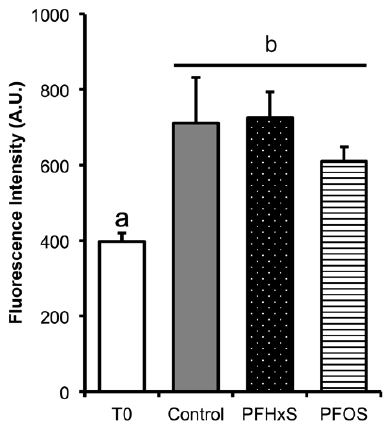
Figure 7. Flow cytometry of tyrosine phosphorylation in boar sperm. The fluorescence intensity obtained by fluorophore Alexa 488 were determined as arbitrary units (AU) did not show significant di ff erences in any of the capacitation conditions tested. A significant di ff erence was observed with the control at time T0, n = 3. a, b Di ff erent lowercase letters indicate the existence of significant di ff erences between treatments ( p < 0.05).